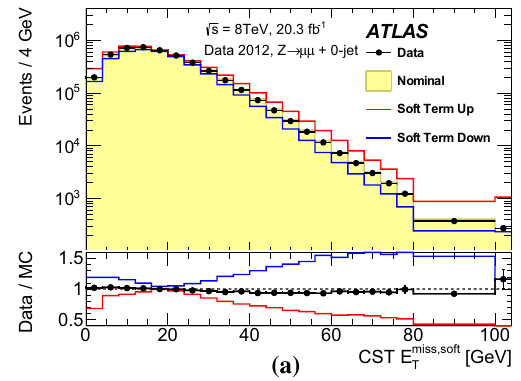
Fig. 25 Distributions of a E miss , soft and b E miss with the CST algo- resulting changes from the variations are added in quadrature, and the T T insets at the bottom of the figures show the ratios of the data to the MC rithm. Data are compared to the nominal simulation distribution as well as those resulting from applying the shifts/smearing according to predictions. The uncertainties are estimated from the data/simulation ratio in Sect. 8.1.2 the scale and resolution systematic uncertainties on the E miss , soft . The T